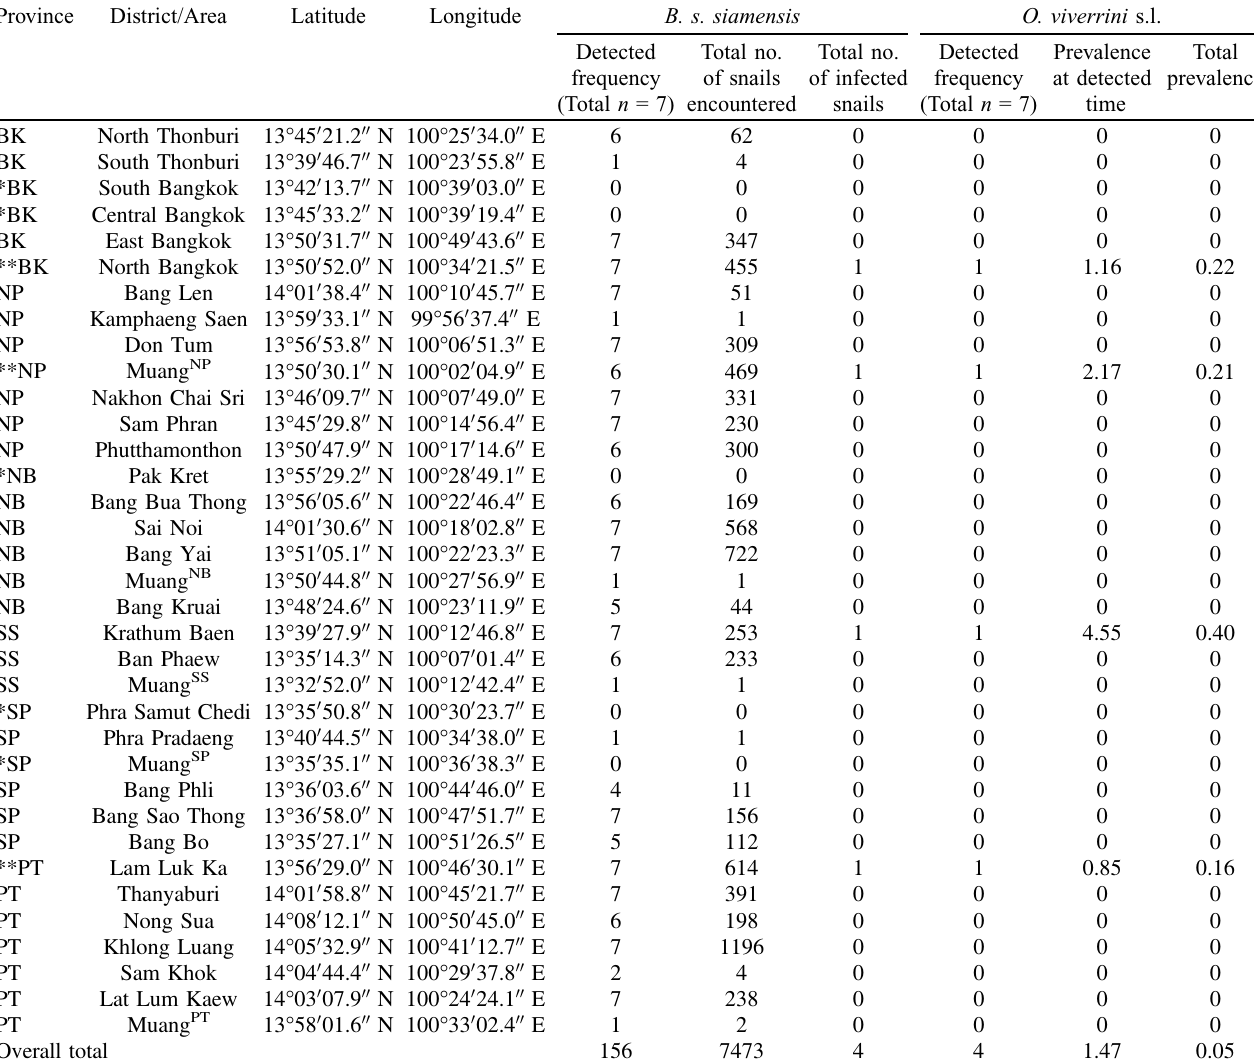
Table 2. Occurrences of Bithynia siamensis siamensis and Opisthorchis viverrini s.l., and prevalences of O. viverrini s.l. infection in each sampling locality in the Bangkok Metropolitan Region, Thailand.